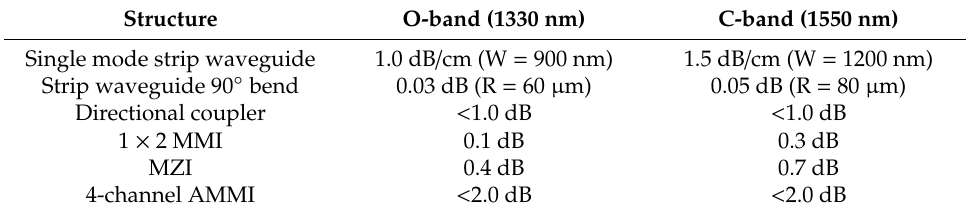
Table 4. Typical insertion loss of devices demonstrated using e-beam lithography on 300 nm stoichiometric SiN in the O and C telecom bands (TE mode). W = single mode waveguide width. R = bend radius.